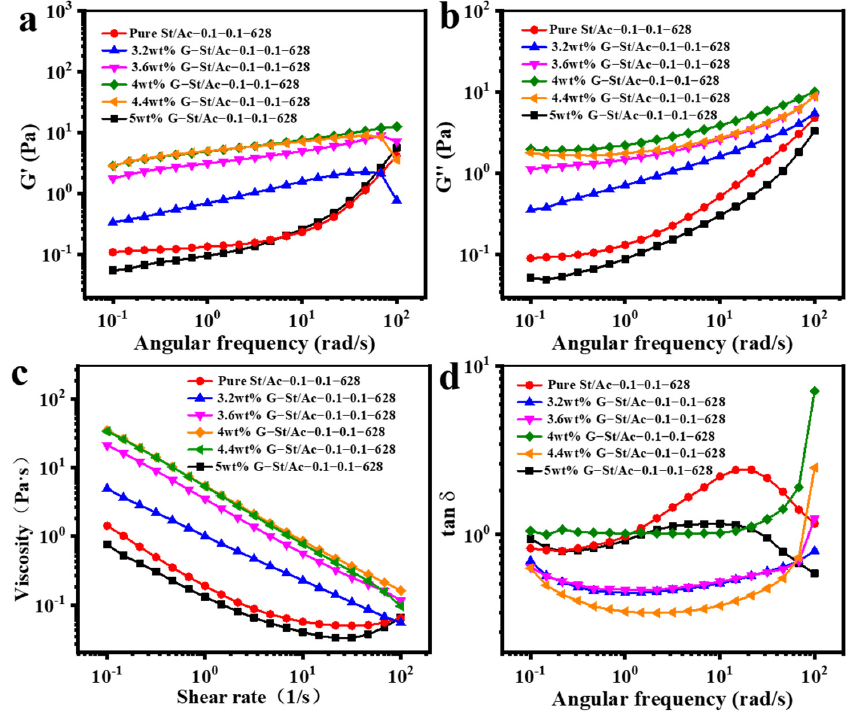
Figure 4. ( a ) Dependence of storage modulus (G ′ ) on strain. ( b ) dependence of loss modulus (G ′′ ) on strain, ( c ) complex viscosity versus angular frequency, and ( d ) dependence of loss tangent(tan δ ) on strain, for the styrene–acrylic emulsion with different addition amounts of aqueous graphene dispersion.